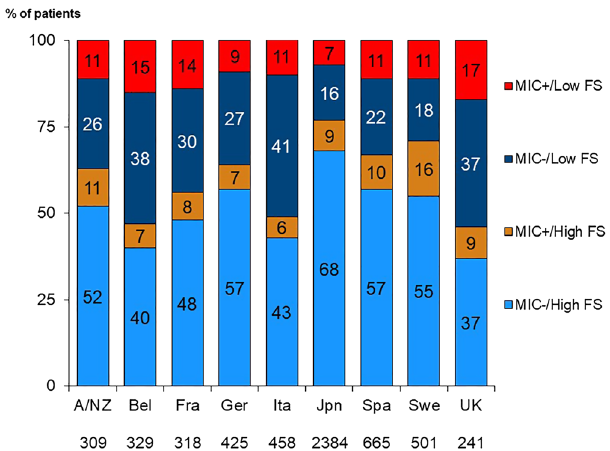
Figure 2. Distribution of MIC and FS combinations by country. MIC, malnutrition-inflammation-complex; FS, functional status; A/NZ, Australia/ New Zealand; Bel, Belgium; Fra, France; Ita, Italy; Jpn, Japan; Spa, Spain; Swe, Sweden; UK, United